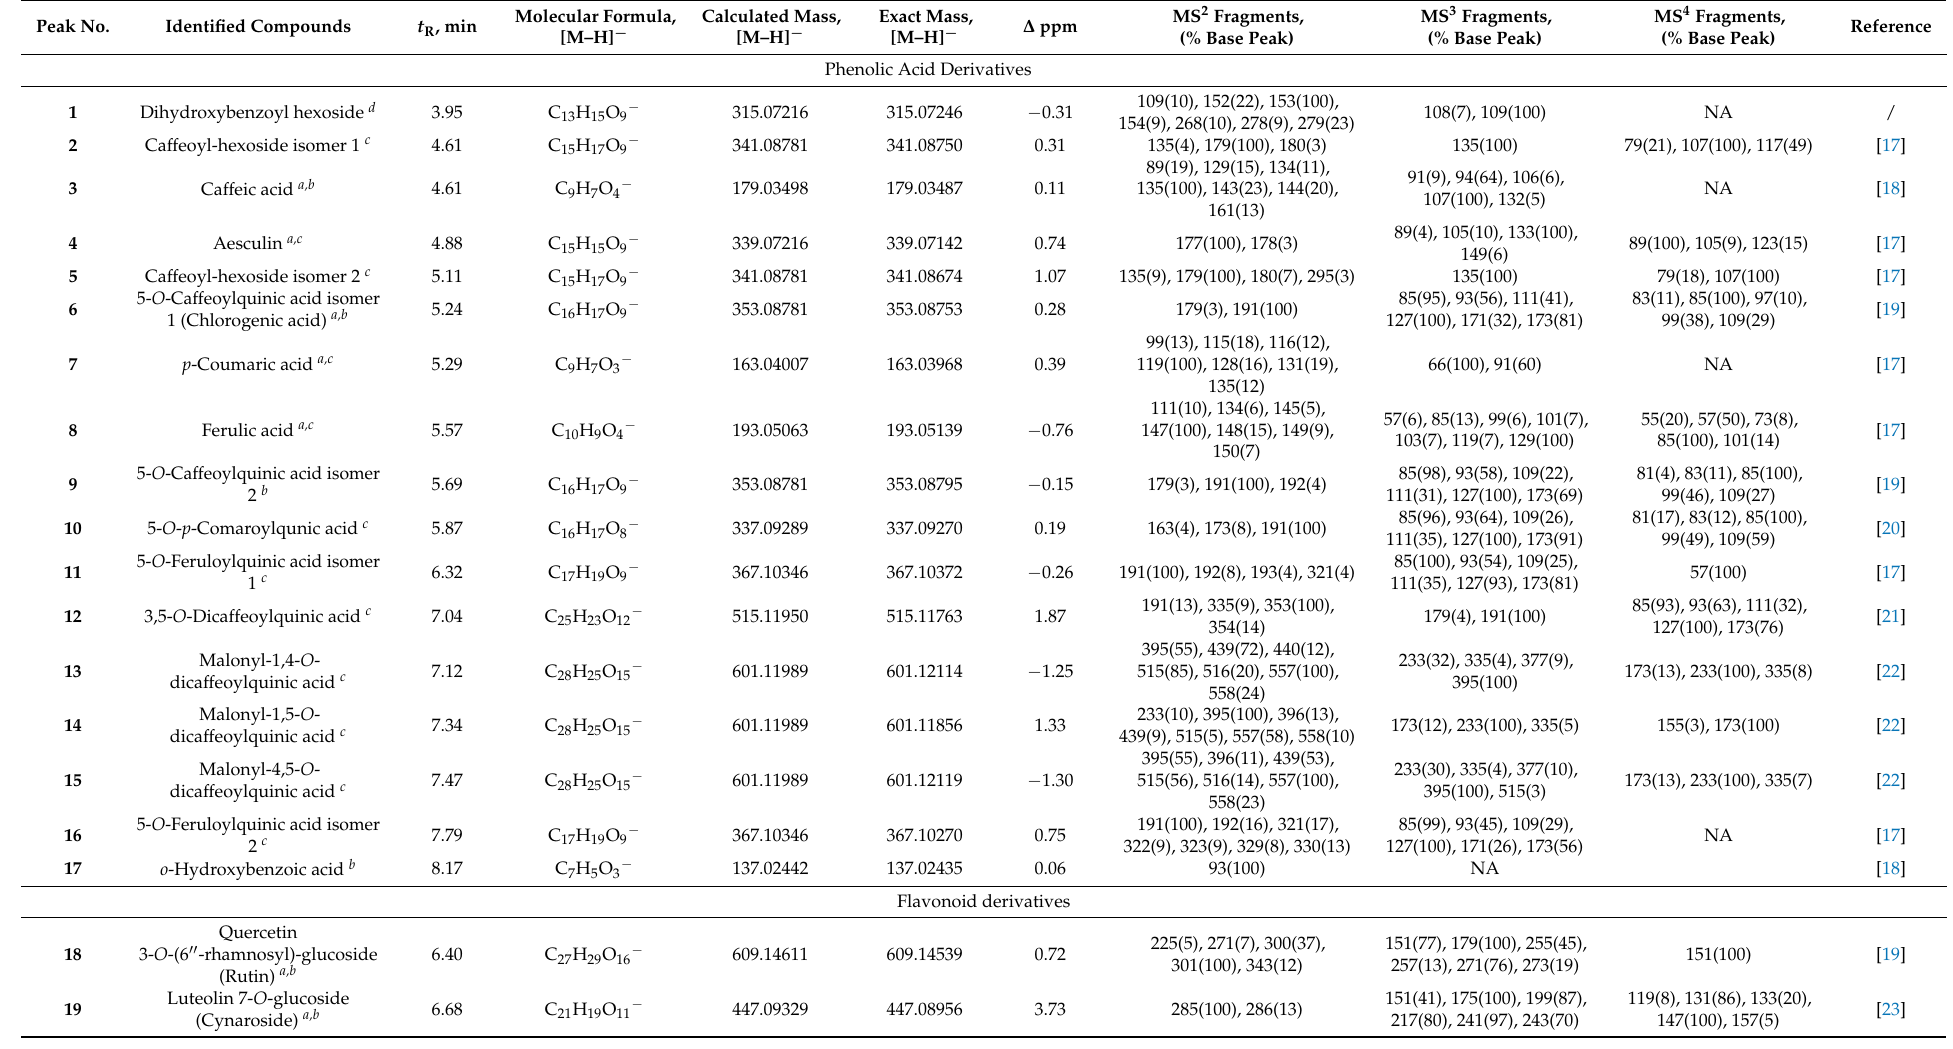
Table 1. High resolution mass spetrometry (HRMS) and MS 4 data for phenolic acids and flavonoids identified in Anthriscus cerefolium